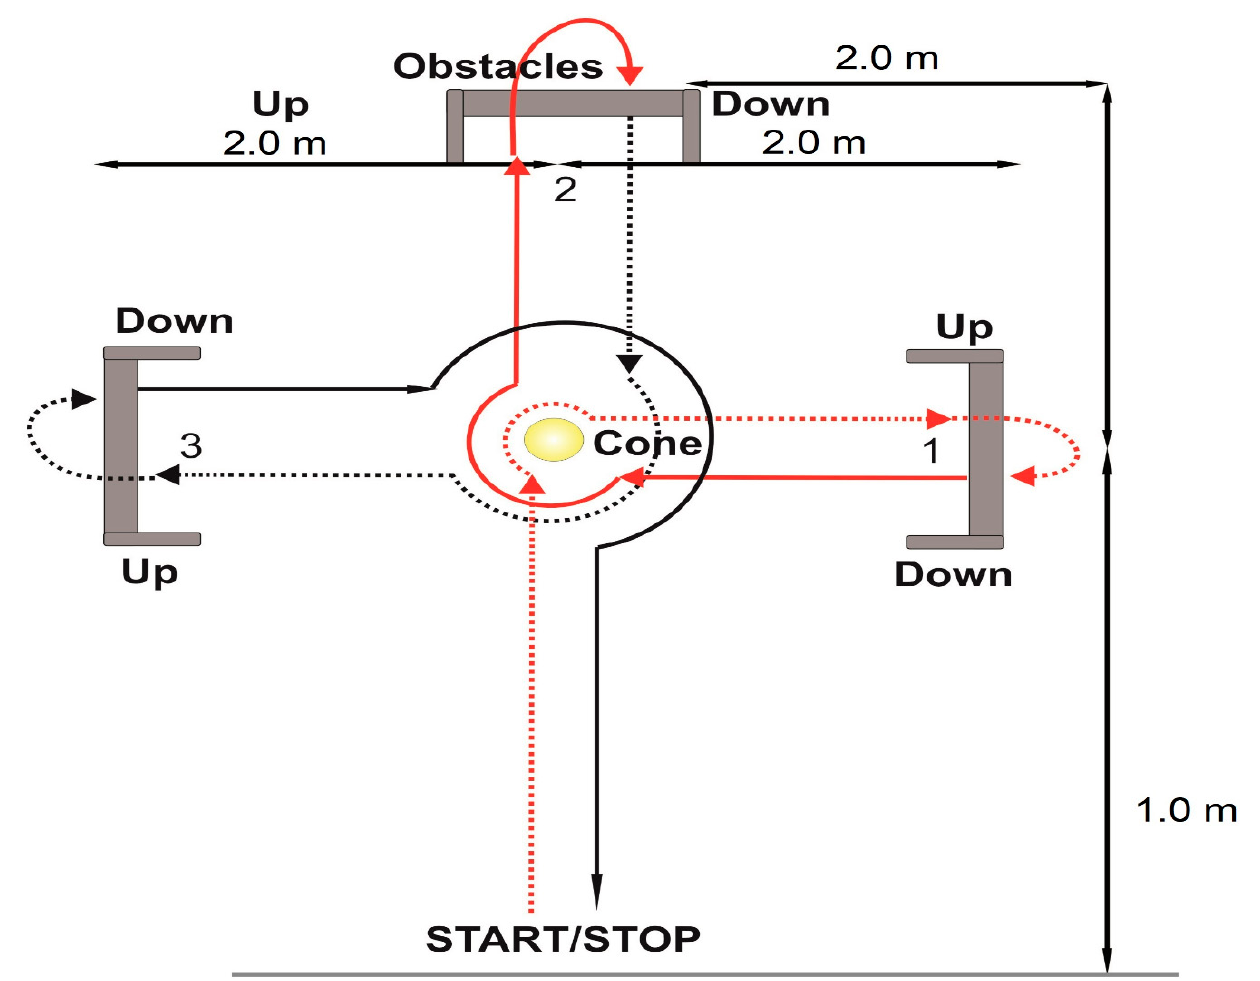
Figure 2. Agility test—the track used in the study.